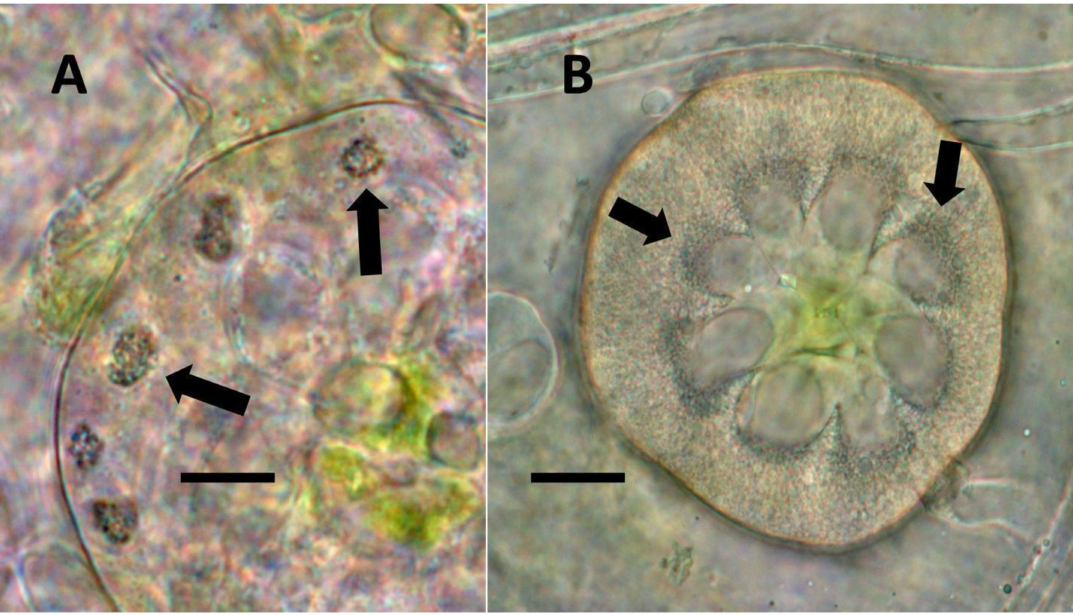
Figure 8. Glandular trichomes of Cannabis sativa . ( A ) Developing glandular trichome of hemp stained with nitro blue tetrazolium to show superoxide (blue-purple color) around clusters of bacteria (arrows) in hair (Bar = 10 µ m). ( B ) More mature glandular trichome of hemp stained with nitro blue tetrazolium to show superoxide (blue-purple color) (arrows) at the interface of central plant cells and peripheral bacteria in hair (Bar = 10 µ